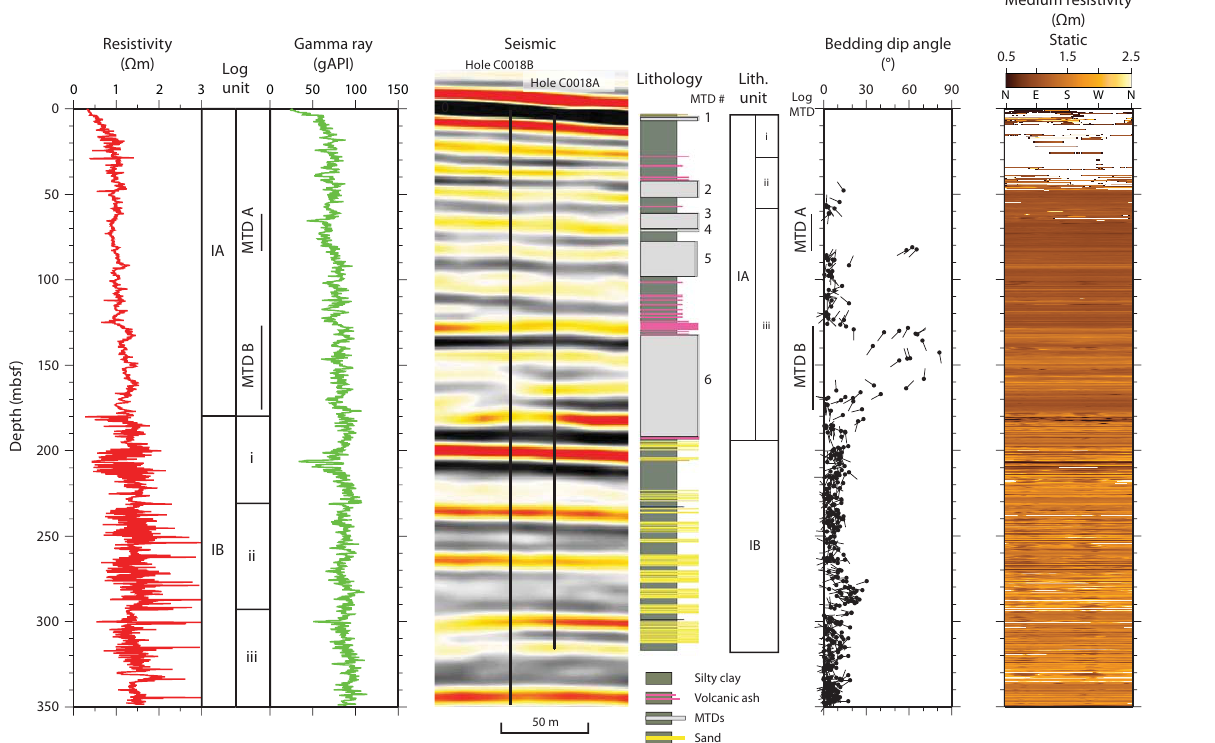
Figure 8. Core-log-seismic integration at Site C0018: LWD data, lithology with mass transport deposit (MTD) intervals and lithologic units, seismic data from In-line 2315 (Kumano 3-D PSDM volume; Moore et al., 2009), bedding dips, and medium button static resistivity.